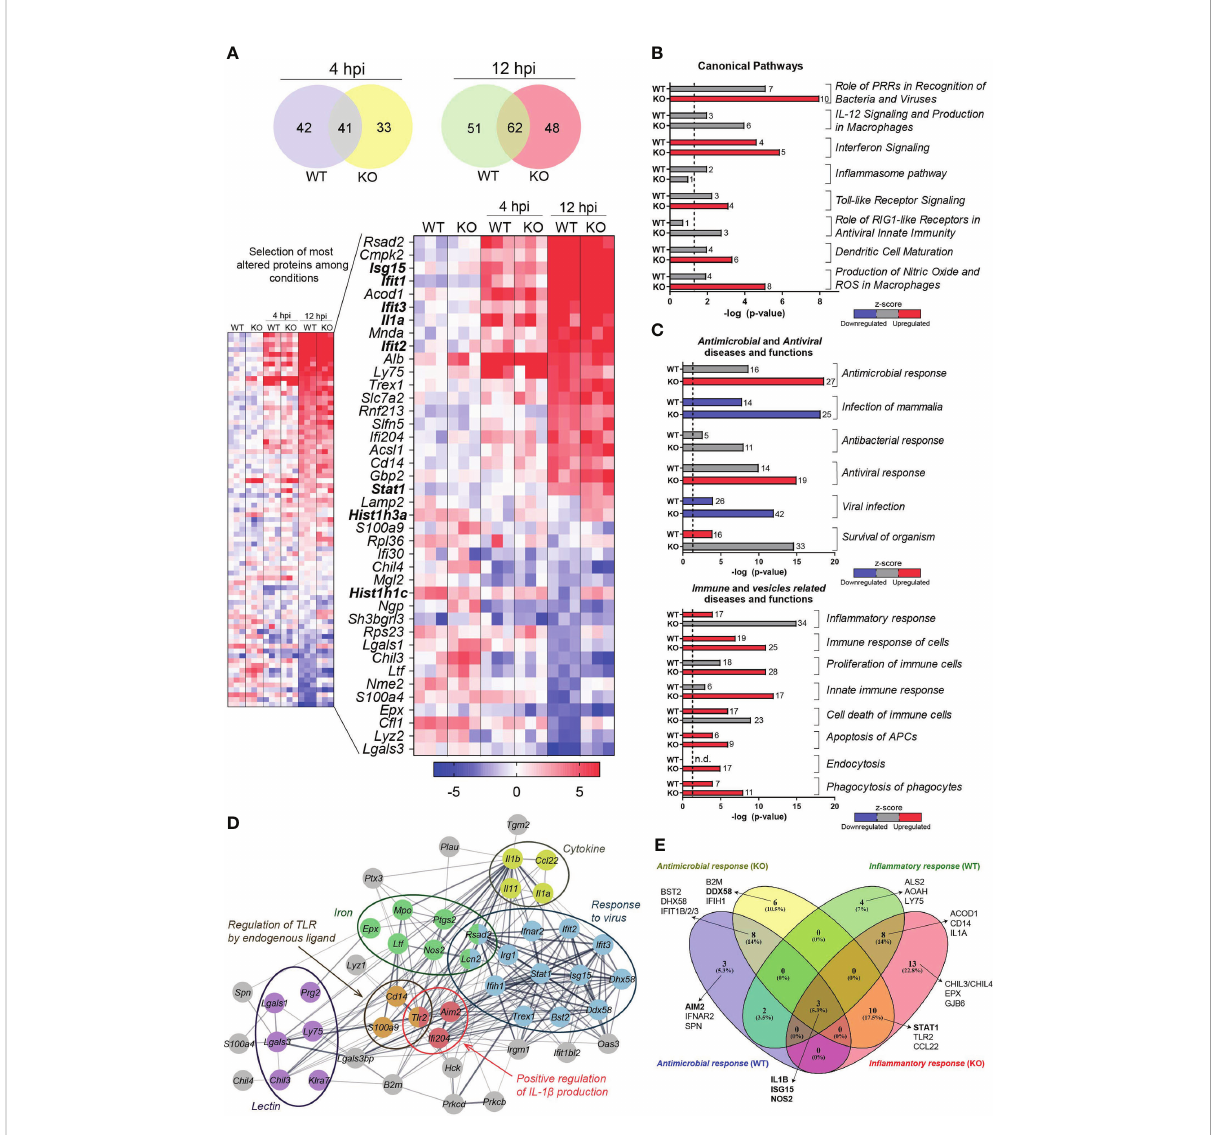
FIGURE 1 Proteome alterations in whole DC lysates after Lm infection. (A) Multiplexed proteomics analysis of Lm- infected or uninfected BMDCs from Hdac6 +/+ (WT) or Hdac6 -/- (KO) mice (n = 3). Venn diagrams show the number of signi fi cant protein abundance changes detected in BMDCs after 4 h or 12 h of Lm infection (FDRq < 0.05 in at least one condition). The smaller heatmap shows quantitative results for those proteins with |Zq| > 2. The larger heatmap shows the top 20 up- and down-regulated proteins (the gene name is indicated) during Lm infection. (B, C) Canonical signaling pathways (B) and diseases and functions (C) predicted as altered 12 hpi by IPA. A – log ( P -value) = 1.3 ( P - value = 0.05) threshold was considered for statistical signi fi cance (dotted line). Four diseases and functions categories were considered: antimicrobial , antiviral , immune and vesicles related diseases and functions. Predicted upregulation (positive z-score, in red) or downregulation (negative z-score, in blue) is shown; z-scores corresponding to uncertain predictions are indicated in grey. n.d, non- detected. Bar numbers represent the number of protein components detected in the corresponding category. (D) Interaction network obtained with the proteins making up the Antimicrobial response and In fl ammatory response categories shown in (C) . This set of proteins was found signi fi cantly enriched in several biological processes ( response to virus (GO: 0009615), FDR=7.6 · 10 -13 ; positive regulation of interleukin-1 beta production (GO: 0032731), FDR= 0.0141) and regulation of TLR by endogenous ligand (mmu5686938 KEGG pathway), FDR= 0.0043) and Uniprot annotations ( lectin (KW-0430), FDR= 0.00026; iron (KW-0408), FDR= 0.00024; and cytokine (KW-0202), FDR= 0.0321). Proteins are labeled according to gene name. (E) Venn diagram represents a comparison of protein components involved in two speci fi c predicted functions: antimicrobial response and in fl ammatory response, taking into account Hdac6 +/+ (WT) and Hdac6 -/- (KO)